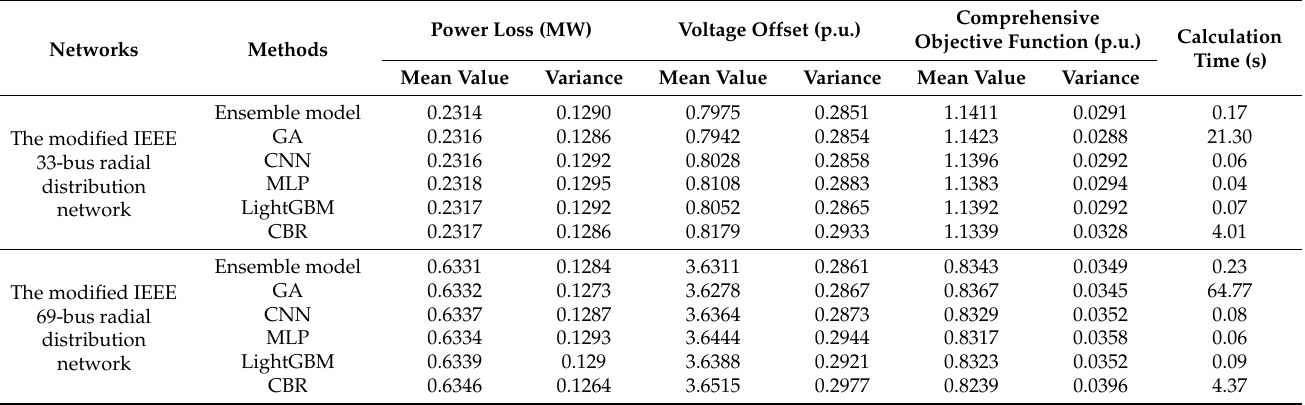
Table 3. The average results of different methods.